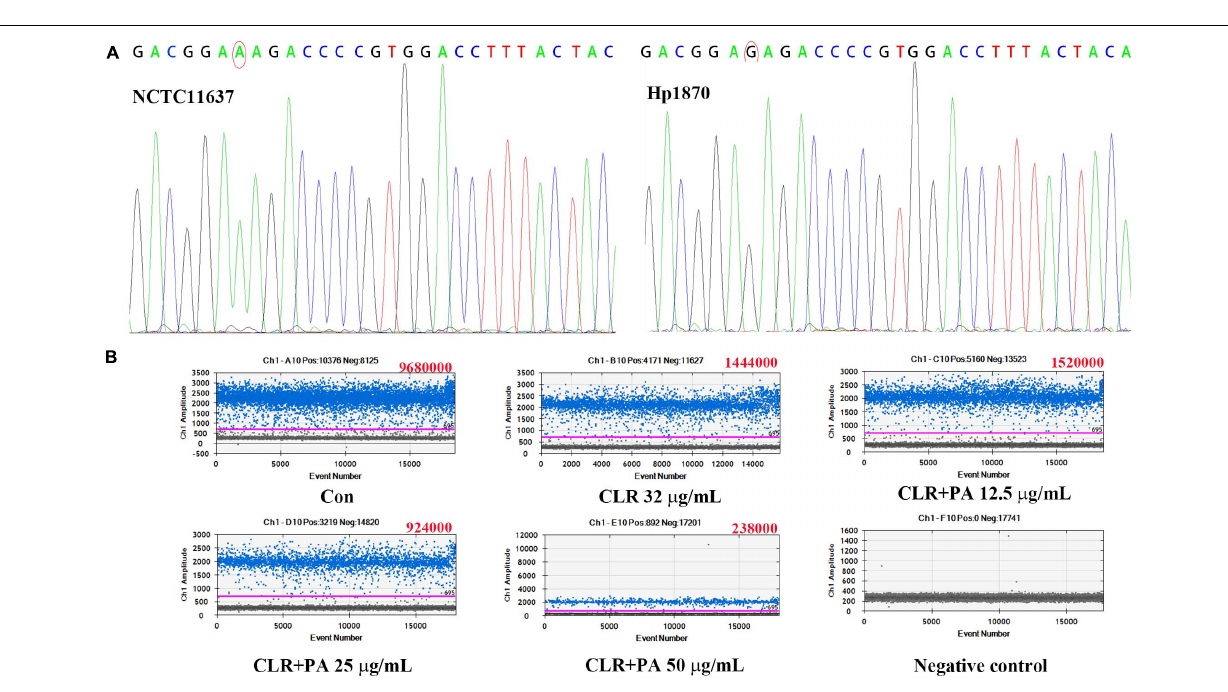
FIGURE 7 | Determination of the mutation site and expression of the mutant gene in the drug-resistant strain Hp1870. (A) First-generation sequencing to determine the mutation of Hp1870. (B) Copy number of A2143G after being treated with DMSO, CLR, and PA. The blue droplets were droplets positive for A2143G, and the copy number value is shown in the upper right corner of each